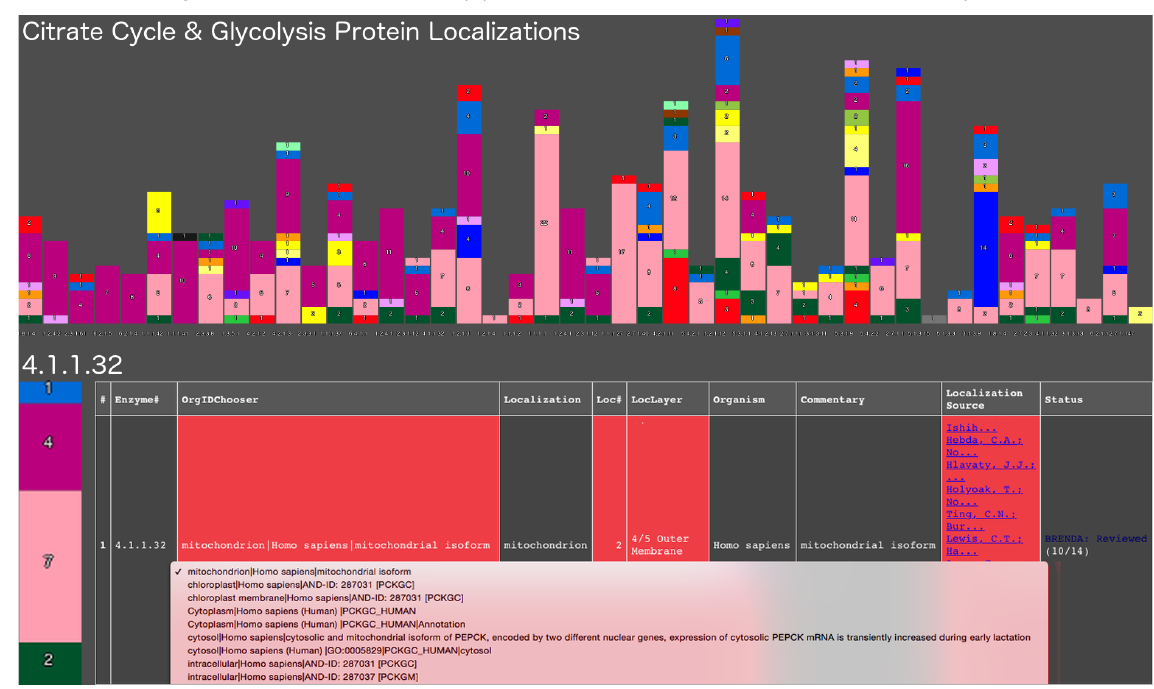
Figure 4: CmPIweb provides a simplified version of the Subcellular Localization Charts. The actually chosen localization for the specific localization scenario is indicated by the colour of the enzyme nodes in Figure 3, in the 2D as well as 3D view. The cell components’ colours are based on the localization colours which are also used for the charts. Top: visual summary of all enzyme localization entries as derived from the databases of CmPI; Bottom Left: The SLC for enzyme 4.1.1.32 selected in Figure 3 Bottom; Bottom Right: The Localization Table entry for 4.1.1.32 including the alternative localization entries triggered by mouse click on the corresponding